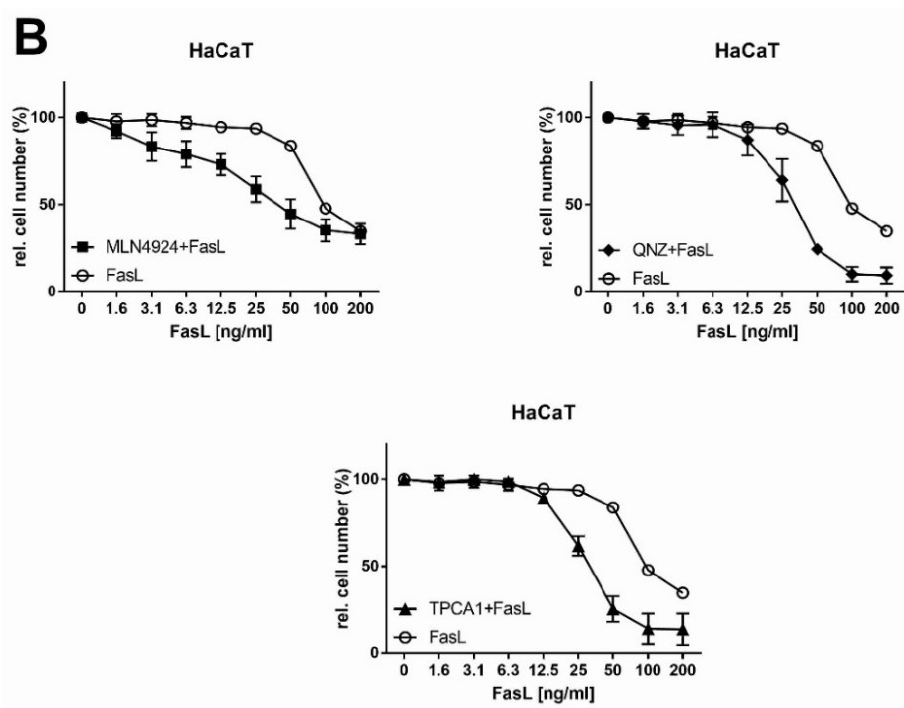
Figure 5. Combination of Cortisol and FasL in HNSCC cell lines. ( A ) HNSCC cell lines (1 × 10 4 /well) were incubated with the indicated concentrations of FasL in combination with the cell line-specific constant IC 10 of Cortisol as indicated in Table 1. The RCN was analysed after 72 h via crystal violet staining, and values were normalised to that of the control (100%). These graphs show data of three independently reproduced experiments with the mean values and standard deviations ( n = 3). Student’s t -test was used for the statistical evaluation of these results to show significant effects when comparing both therapies. To compare treatment efficacies, Tallarida’s interaction index was determined as indicated in the material and method section. ( B ) HaCaT cells (1 × 10 4 /well) were incubated with the indicated concentrations of FasL in combination with IC 10 concentration of MLN4924, QNZ and TPCA1 as indicated in Table 1. The RCN was analysed after 72 h via crystal violet staining, and the values were normalised to that of the control (100%). Three independent experiments were carried out with triplicate cultures. These graphs show data of three independently reproduced experiments ( n = 3) with the mean values and standard